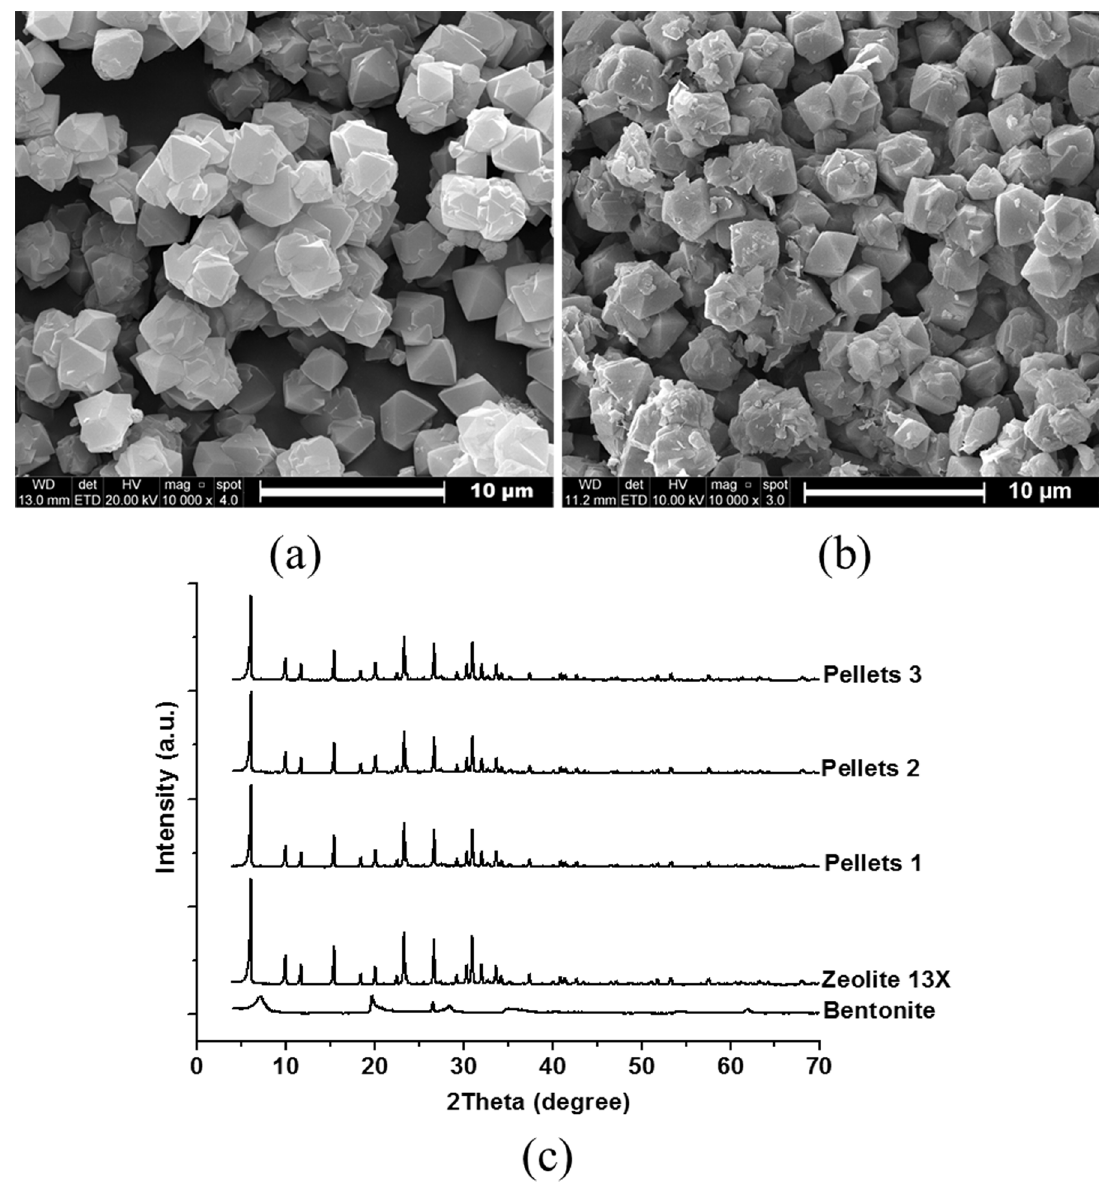
Figure 4. Characterization of 13X zeolite by: a) FESEM of zeolite 13X powder, b) FESEM of zeolite 13X pellets; and c) XRD patterns of bentonite, pellets and powder of 13X